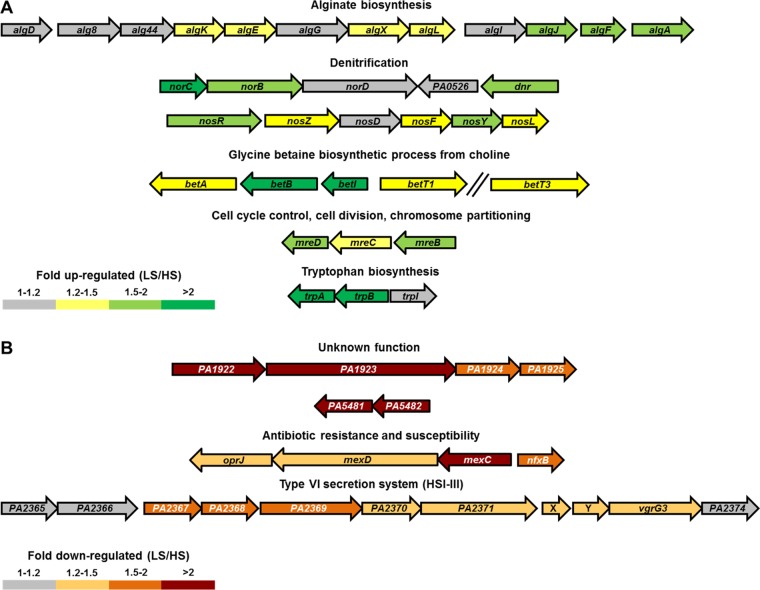
Overview of the genetic regions that contain upregulated (A) or downregulated (B) genes under low fluid shear versus high fluid shear conditions for the key affected functional classes. X and Y represent PA14 genes PA14_33980 and PA14_33970, respectively, which are not present in the PAO1 genome. LS, low fluid shear. HS, high fluid shear. The // symbol indicates that this gene is located at a distant position in the genome. All adjacent genes that are transcribed in the same direction are considered to constitute an operon here.